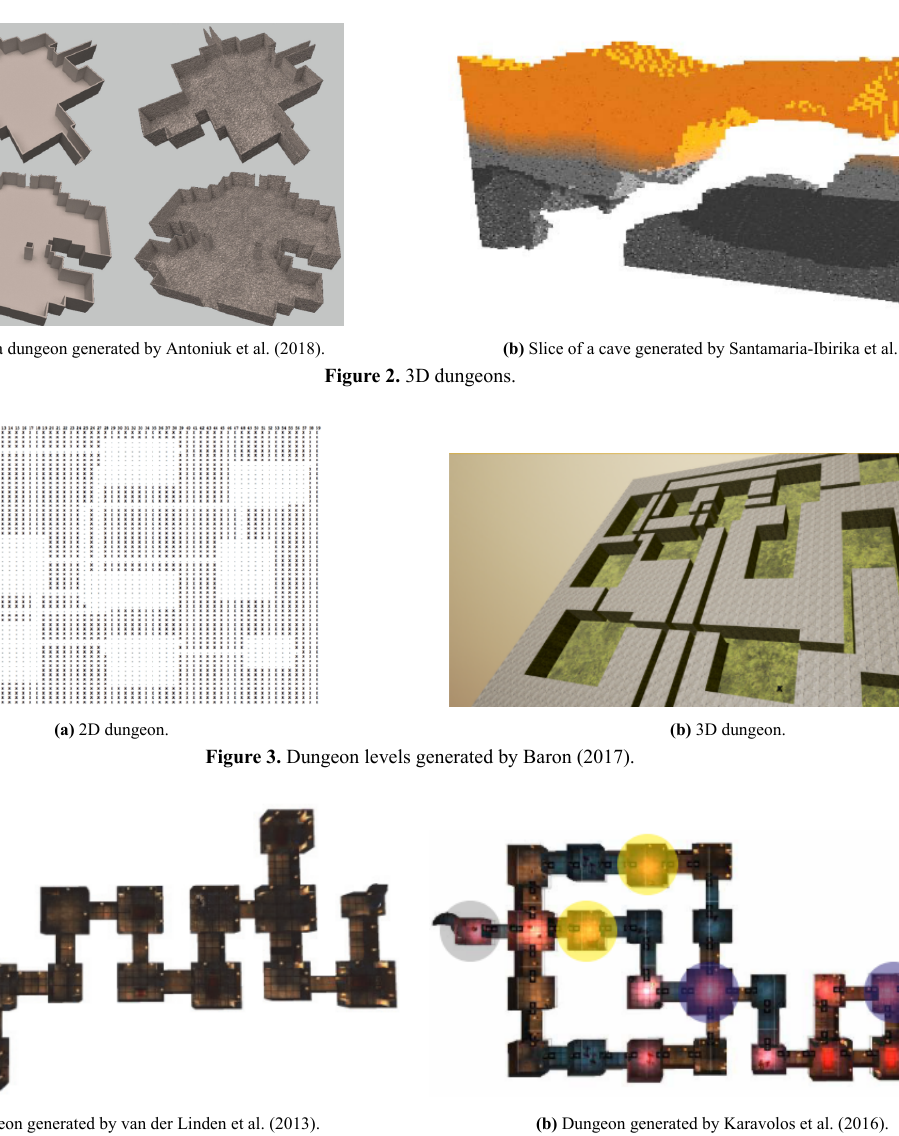
Figure 4. Dungeon levels generated for Dwarf Quest